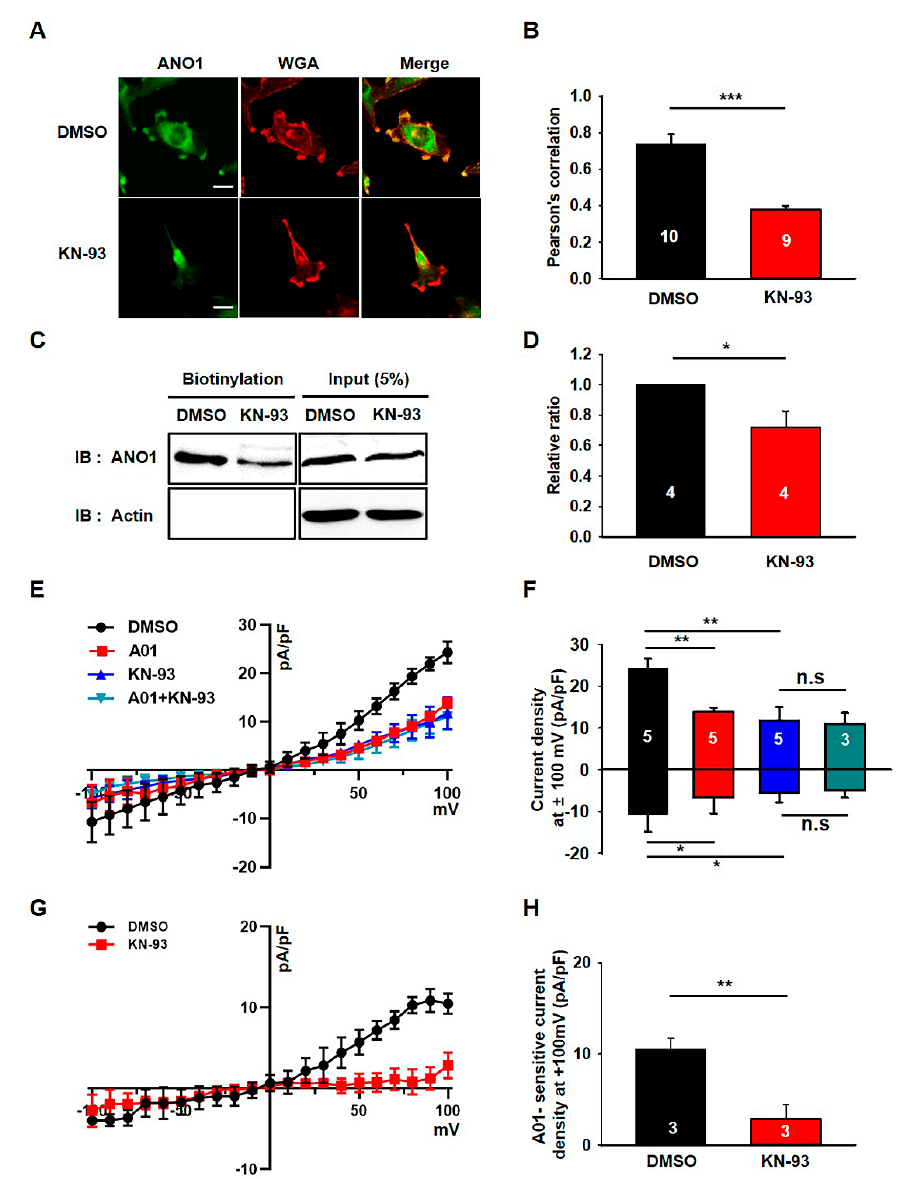
Figure 2. KN-93 reduces the surface expression and activity of ANO1 in U251 cells. ( A ) U251 cells treated with DMSO or KN-93 were imaged using antibodies against ANO1 and WGA647 (WGA), a plasma membrane marker. Scale bar, 20 µ m. ( B ) The Pearson’s correlation coe ffi cient for ANO1 with KN-93 was significantly less than the value obtained for ANO1 with DMSO in U251 cells. ( C ) Cell surface biotinylation results from membrane protein fractions from U251 cells treated with DMSO or KN-93. ( D ) The summary bar graph showing data obtained from three independent experiments as in ( C ). ( E ) Averaged traces of whole-cell currents of U251 cells treated with DMSO or T16Ainh-A01, an ANO1 inhibitor. ( F ) The summary bar graph shows the inhibitory e ff ect of KN93 or T16Ainh-A01 on ANO1 current amplitude at ± 100 mV. ( G ) Averaged traces of normalized T16Ainh-A01-sensitive currents of U251 cells treated with DMSO or KN-93. ( H ) The bar graph shows normalized T16Ainh-A01-sensitive current densities ( G ) at + 100 mV. Number on each bar indicates n for each condition. All values are mean ± s.e.m. P -values were obtained with Student’s t-test. * p < 0.05, ** p < 0.01, and *** p < 0.001. n.s means not